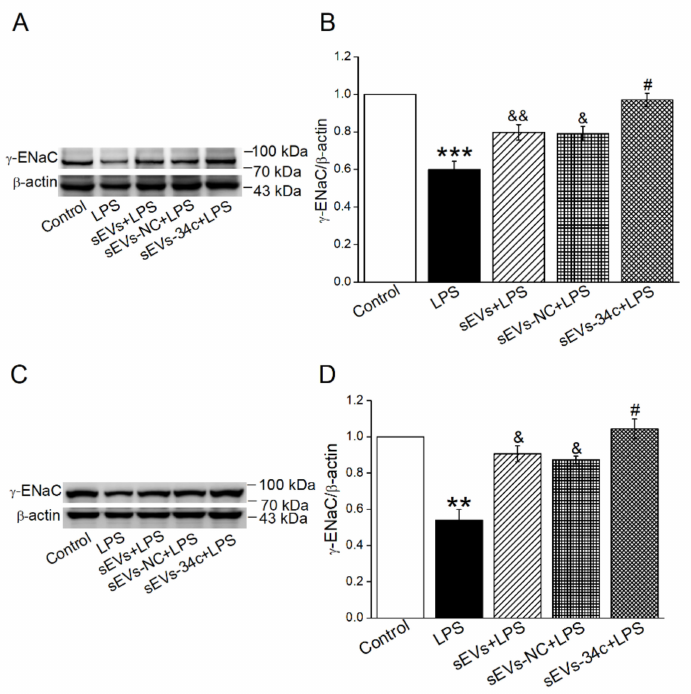
Figure 4. Overexpressing miR-34c in BMSC-sEVs attenuated LPS-inhibited γ -ENaC expression in H441 and mouse AT2 cells. ( A , C ) Representative blots of γ -ENaC protein in Control, LPS (LPS, 24 h, 10 µ g/mL), sEVs (20 h, 20 µ g/mL) +LPS (24 h, 10 µ g/mL), sEVs -NC (20 h, 20 µ g/mL) + LPS (24 h, 10 µ g/mL) and sEVs -34c (20 h, 20 µ g/mL) + LPS (24 h, 10 µ g/mL) group in H441 and AT2 cells, respectively. ( B , D ) Graphical representation of data obtained from Western blot and quantified through gray analysis ( γ -ENaC/ β -actin) ( n = 5). Note: ** p < 0.01, *** p < 0.001, compared with Control group; & p < 0.05, && p < 0.01, compared with LPS group; # p < 0.05 compared with sEVs -NC + LPS